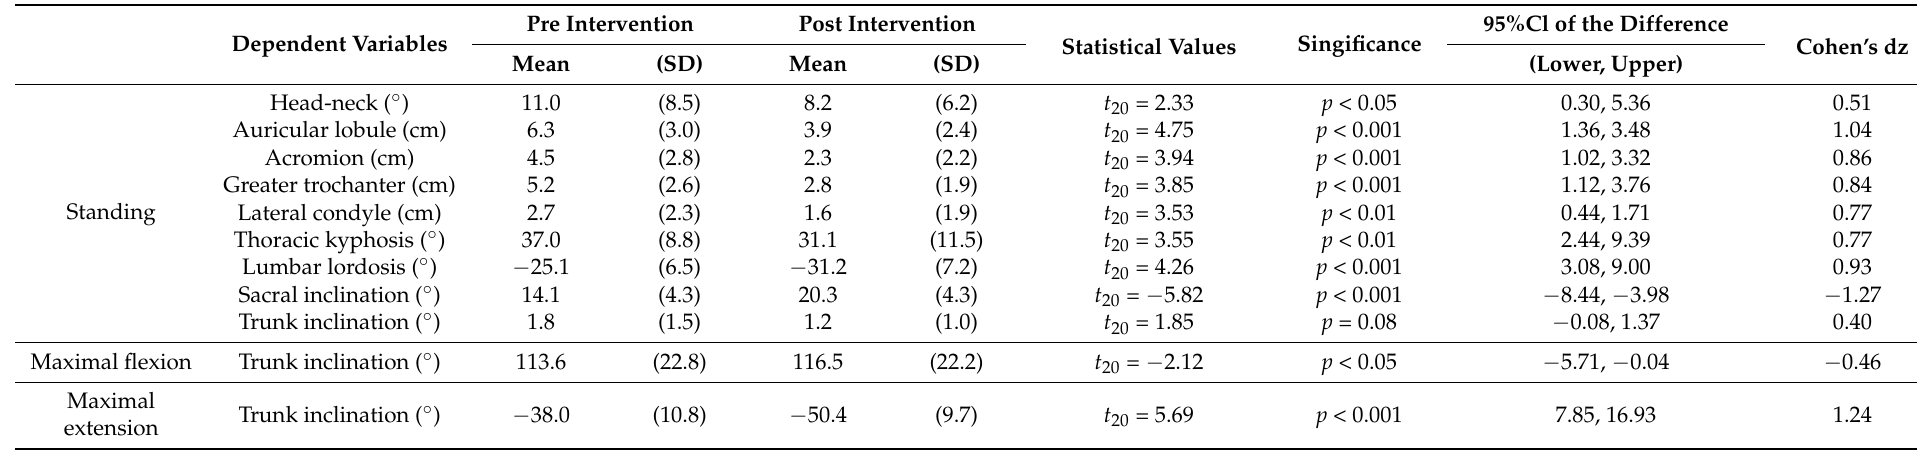
Table 1. Means and standard deviations of postural measurement parameters pre-and post-intervention.